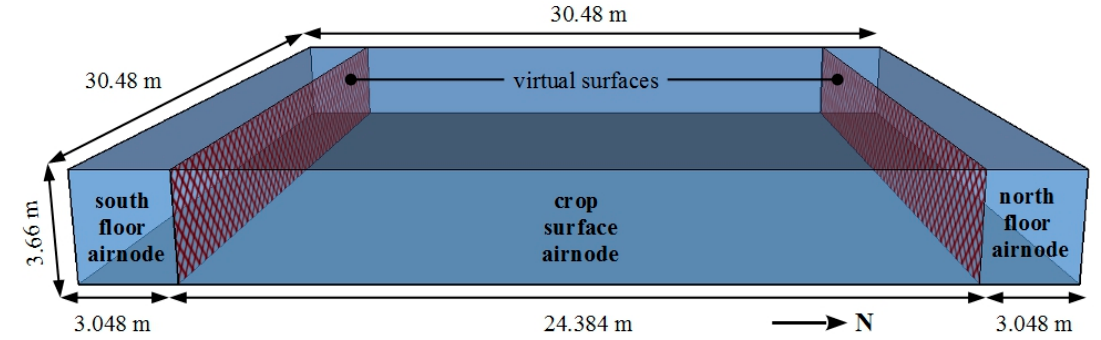
Figure 5. Schematic showing the two virtual surfaces that separate the three airnodes.